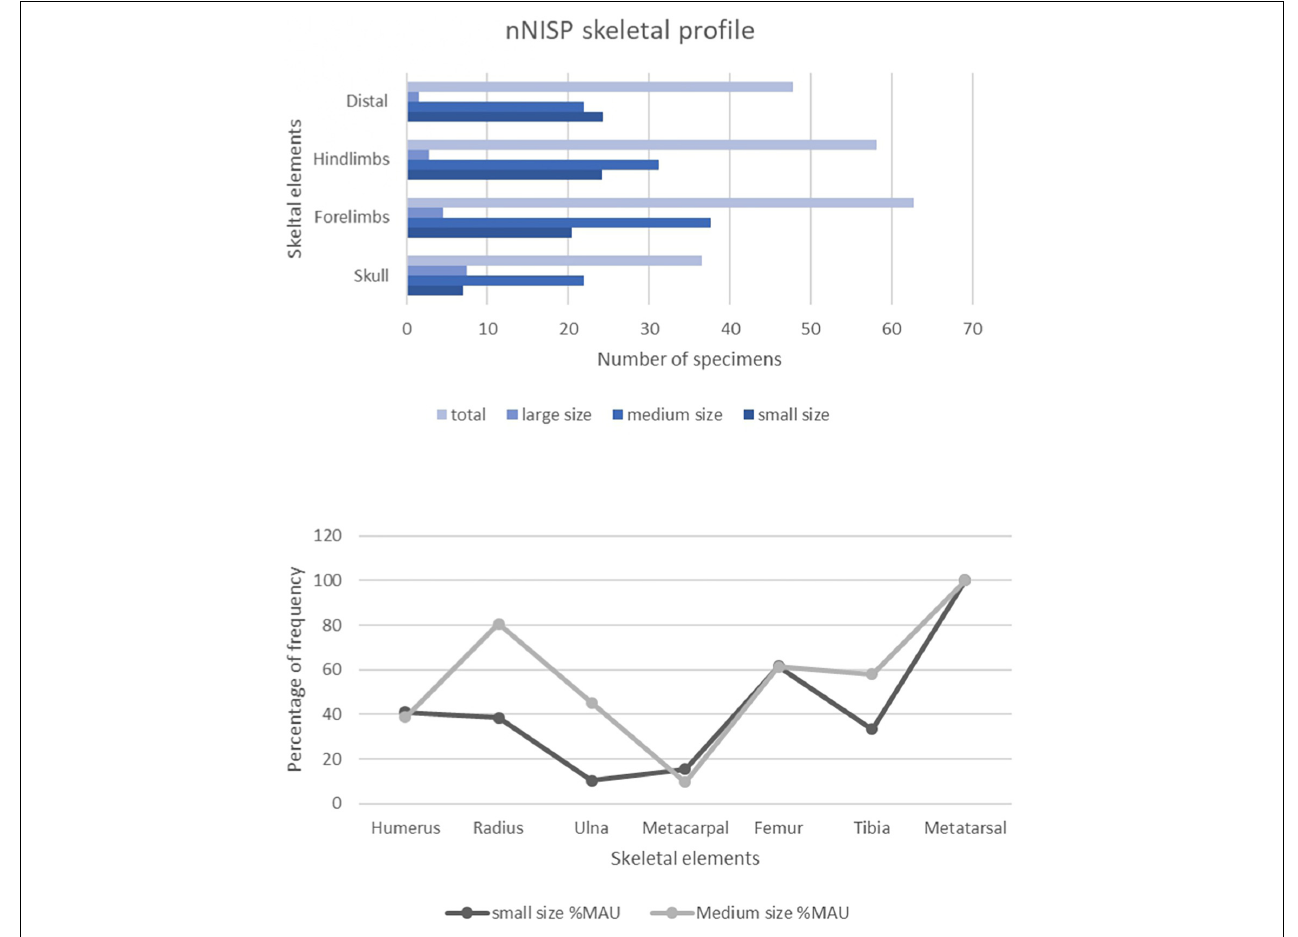
FIGURE 4 | Skeletal profiles of Ewass Specimens created from normed NISP (nNISP). Skeletal profiles of Ewass Oldupa specimens created from the normed Number of Identified Specimens compared with %MAU profiles using long bone portions of small and medium size classes. Percentage Minimum Animal Units (%MAU) profile created using the long bone portions of small and medium size classes calculated from the MNE based on Binford